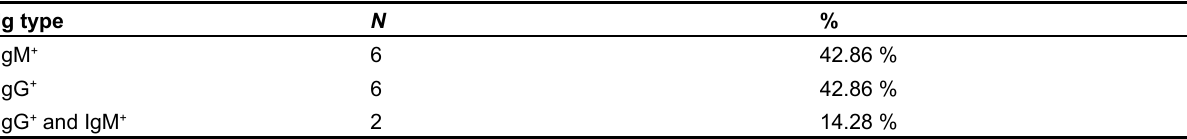
Table 2. Prevalence of SARS-CoV2 antibodies in false positive serology Ig